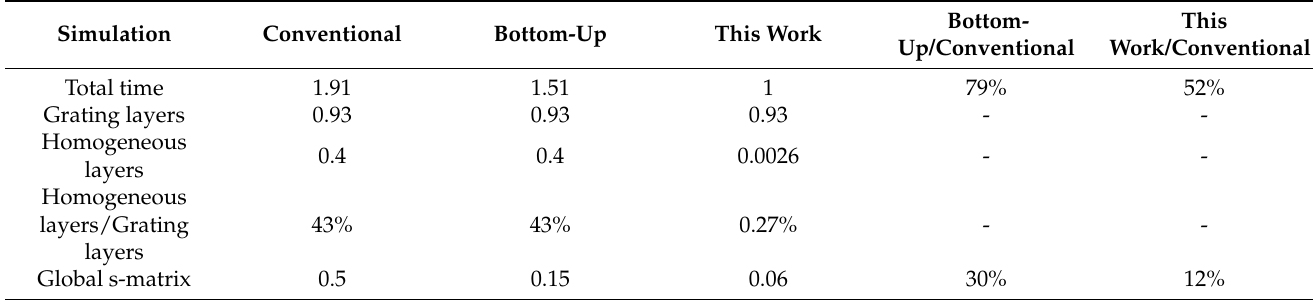
Table 2. Normalized simulation time of the 3D multilayer nanohole structure.